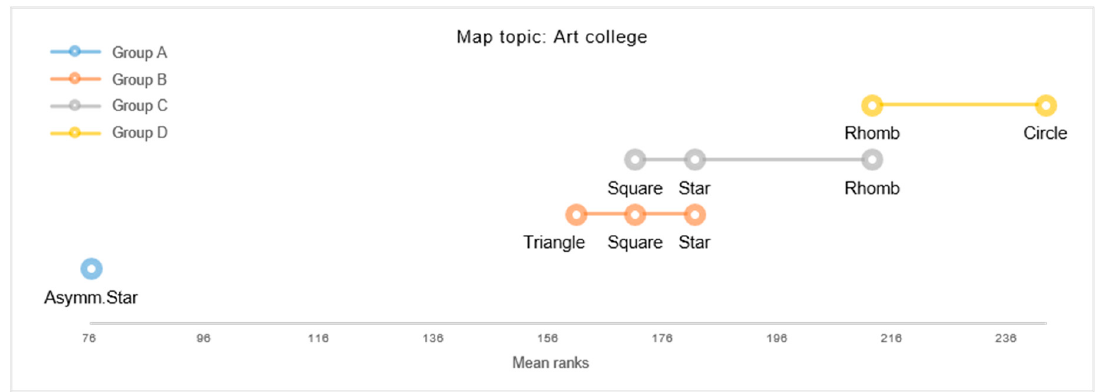
Figure 9. Map #5: Results of multiple pairwise comparisons, indicating groups of (dis)similar symbol-content congruence.